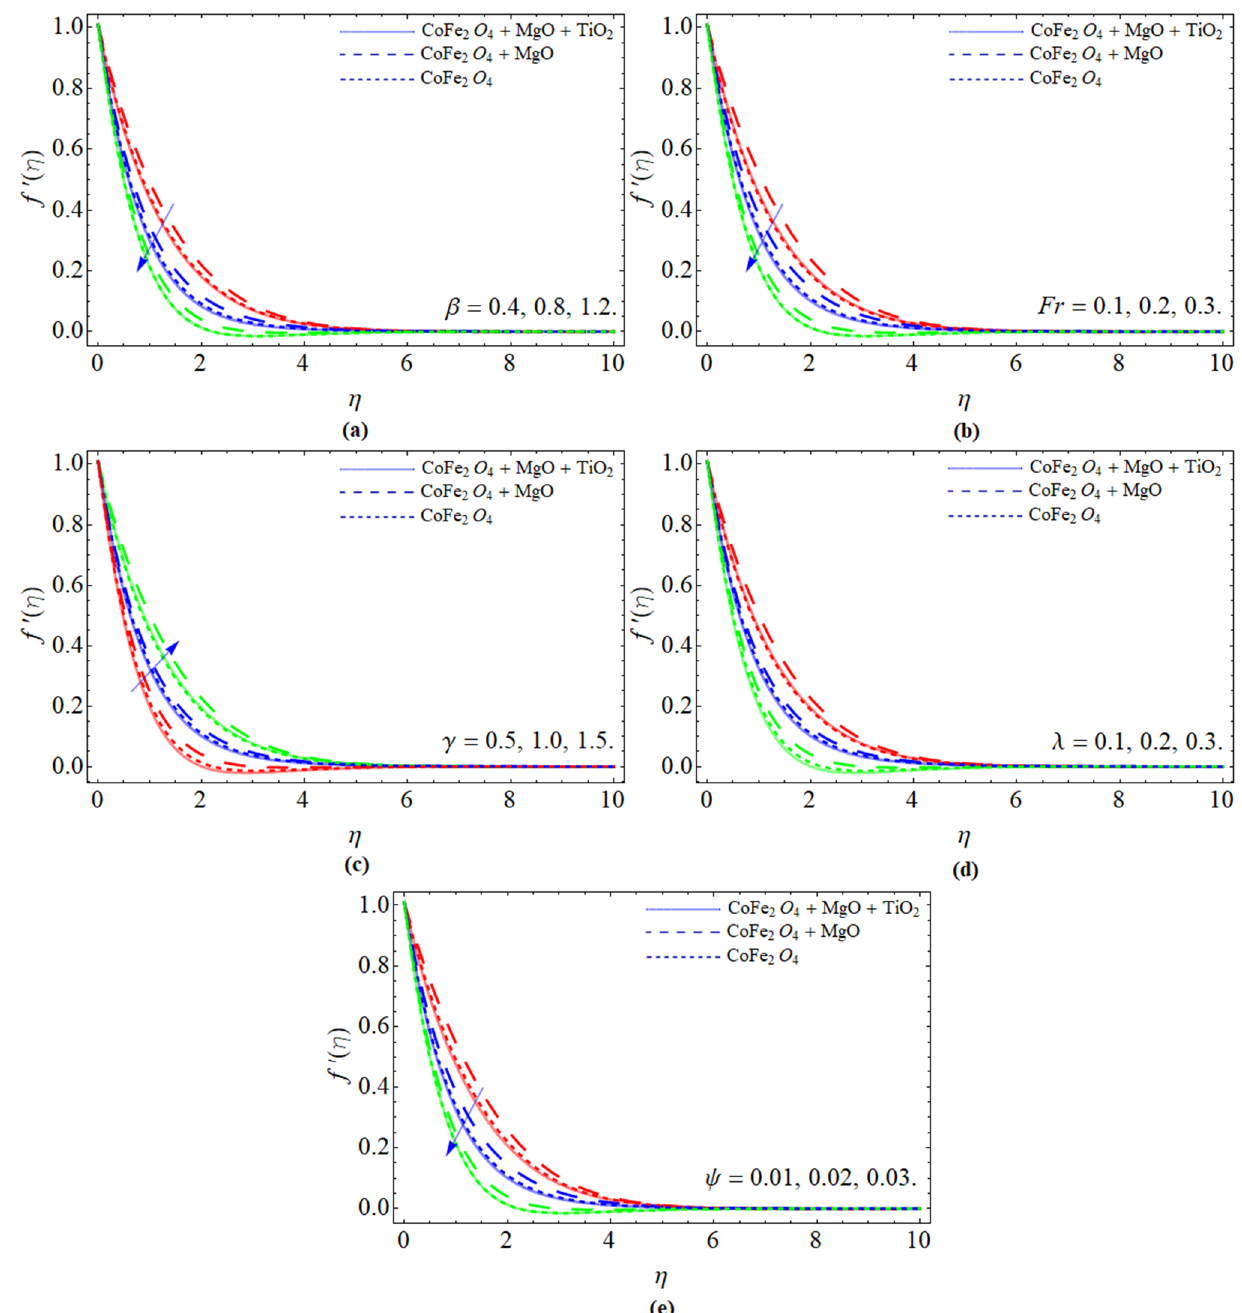
Figure 2. The presentation of velocity ( ) f η ′ profile against the variation of ( a ) magnetic term β , γ , ( d ) inverse magnetic Prandtl number λ ( b ) Darcy Forchhemier term Fr , ( c ) curvature constant ( b ) Darcy Forchhemier term Fr , ( c ) curvature constant γ , ( d ) inverse magnetic Prandtl number λ , and ψ , and ( e ) nanoparticles volume friction . . ( e ) nanoparticles volume friction ψ